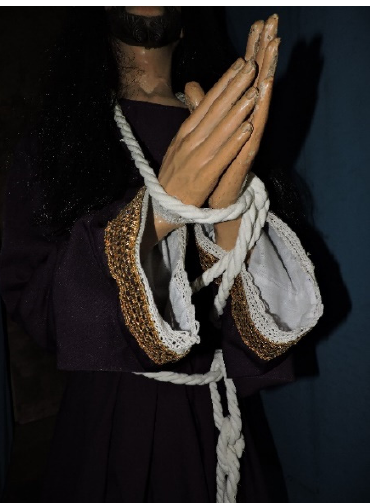
Figure 4. Agony in the Garden , in the Church of the Third Order of Mount Carmel in Mogi das Cruzes. Polychrome wood sculpture (116 × 40 × 57cm), eighteenth century. Photo by Lia Brusadin, 1 January 2017.